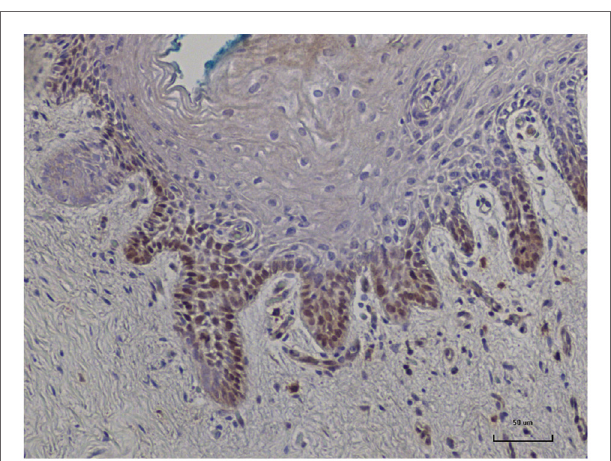
FigUre 5 | hPV e7 protein expression identified in hPV type 18 positive cervical intraepithelial neoplasia (cin 1) . This is a positive control for Cervimax antibodies used in the immunohistochemistry analyses.